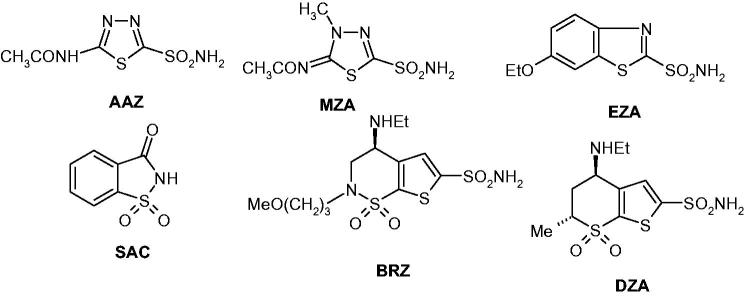
Clinically used sulfonamides with CA inhibitory activity1–3.